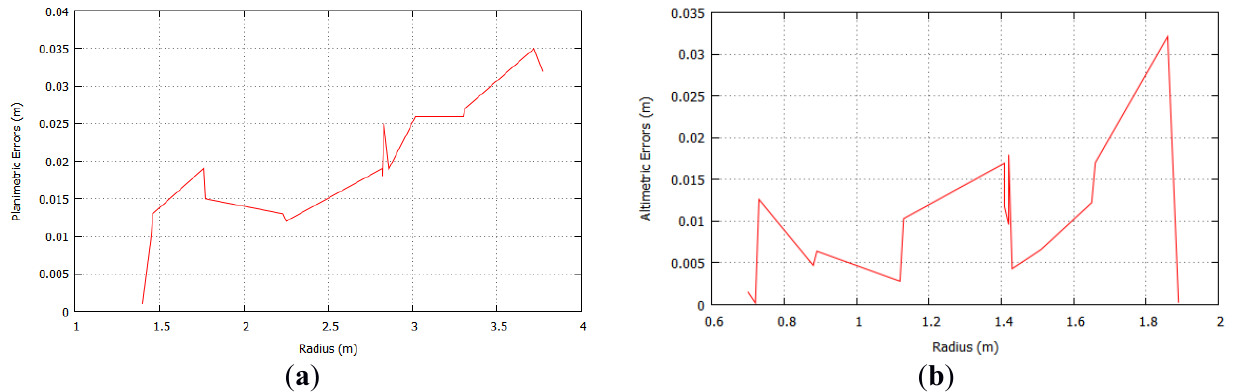
Figure 8. Graph comparing the errors against the radial distance from the panel center: ( a ) PE in the XY coordinates and ( b ) AE in the Z coordinate.